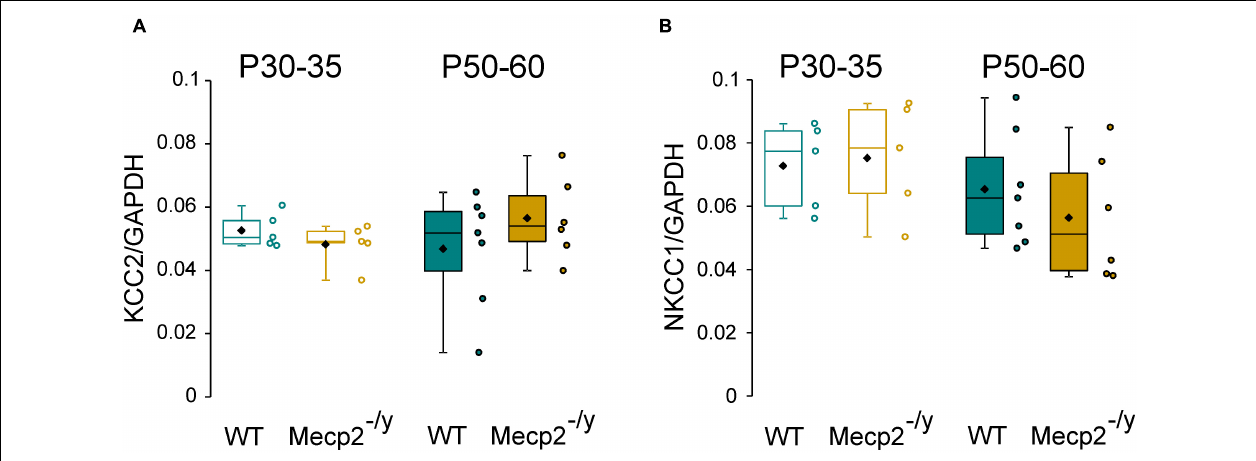
FIGURE 2 | mRNA expression of KCC2 and NKCC1 in wild-type (WT) and Mecp2 - / y hippocampi. Box plots of normalized KCC2 (A) and NKCC1 (B) mRNA expression in the hippocampi of P30–35 and P50–60 WT and Mecp2 - / y mice.